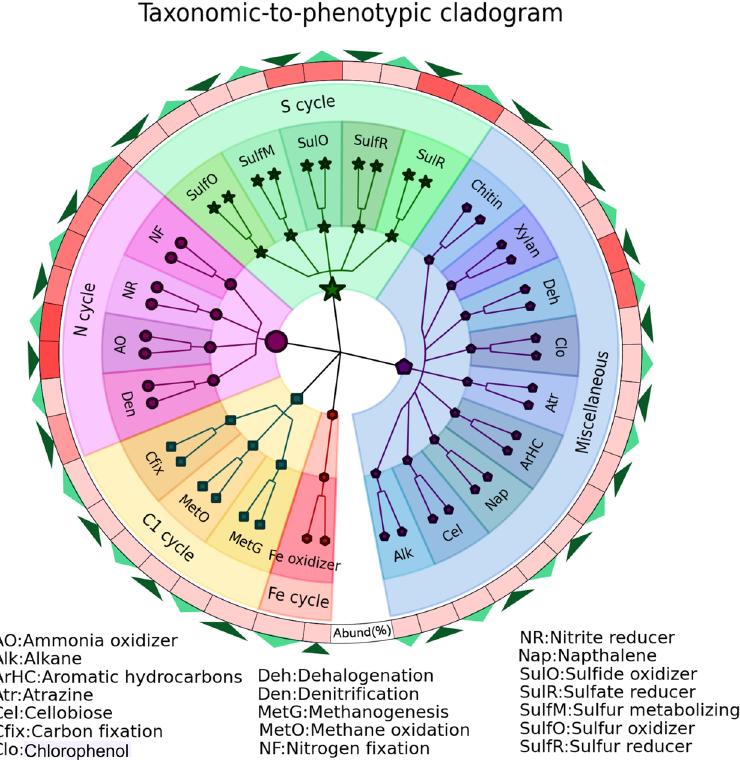
Figure 4. Sapropels’ taxonomic-to-phenotipic cladogram showing the putative metabolic profiles of sapropels’ microbial communities (based on 16 S rRNA gene). The cladogram does not reflect the functional status of the microbial communities, but rather their metabolic potential. The red internal ring is a circular heatmap; the colour intensity is proportional with the number of sequences affiliated with a metabolic profile. The emerald triangles ( ▴ ) correspond to the metabolic profiles of Ursu sapropels, while the inverted ( ▾ ) green ones correspond to Fara Fund